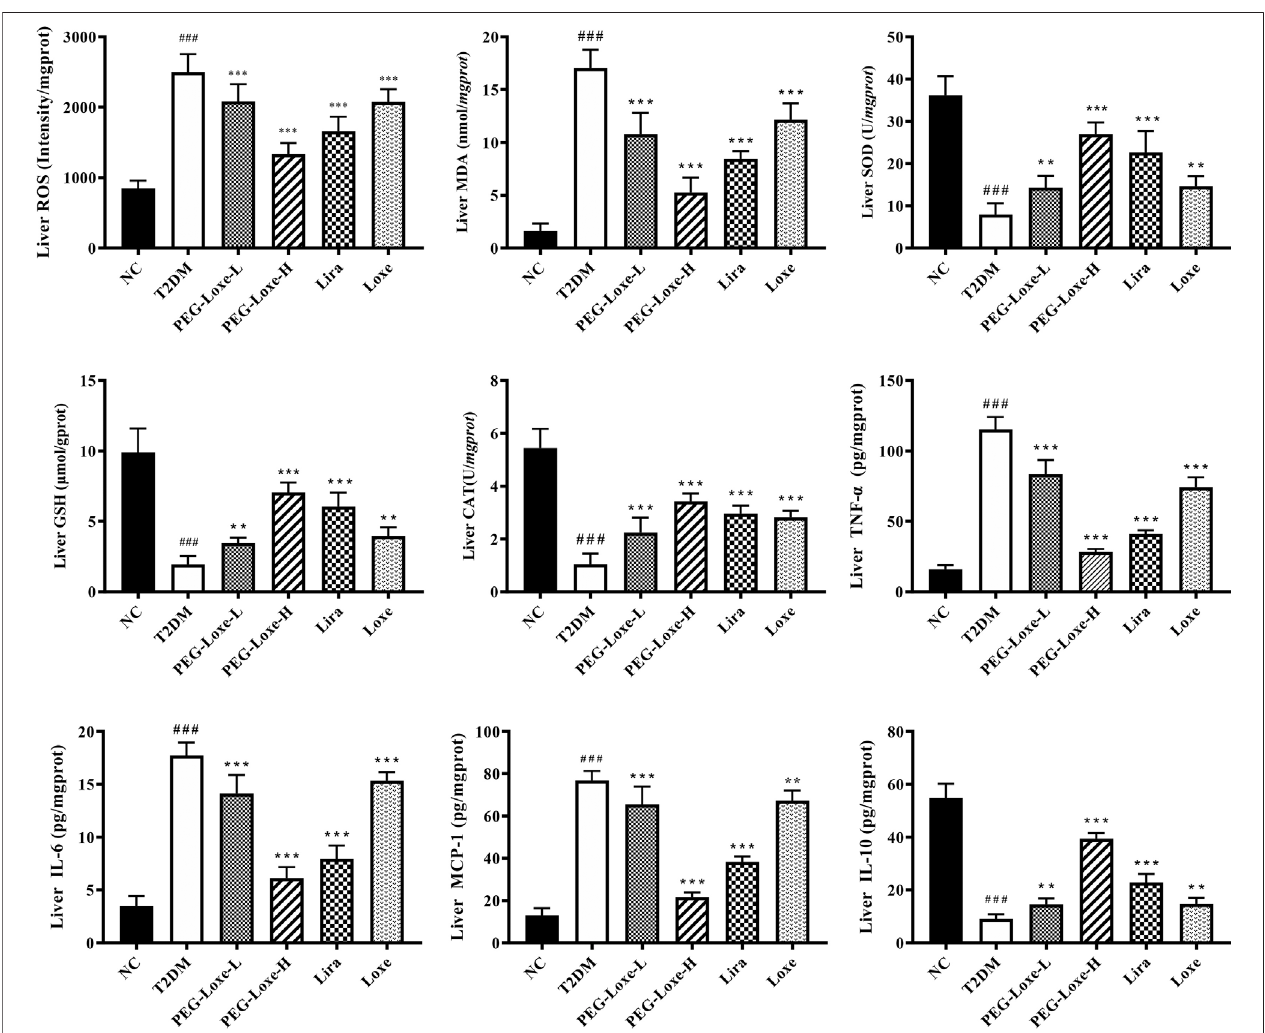
FIGURE 3 | Polyethylene glycol loxenatide (PEG-Loxe) improved oxidative stress and the production of in fl ammatory factors in the liver of db/db mice. Oxidative stress parameters, including reactive oxygen species (ROS), malondialdehyde (MDA), glutathione (GSH), superoxide dismutase (SOD), and catalase (CAT), and in fl ammatory factors, including tumor necrosisfactor- α (TNF- α ), interleukin-6 (IL-6), monocyte chemotactic protein-1 (MCP-1), and interleukin-10 (IL-10), were detected using the ELISAassay. Dataare presented as themean ± SD; n (cid:2) 8; ### p < 0.001 compared tothe normal control group; ** p < 0.01 and *** p < 0.001compared to the T2DM